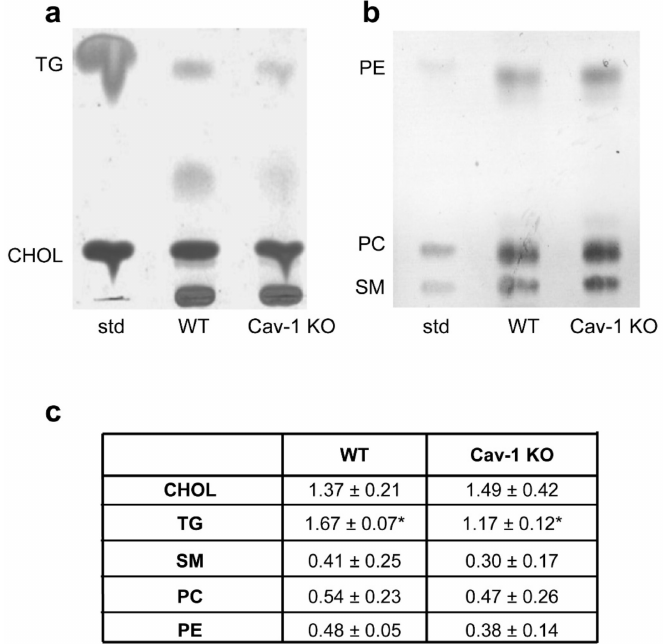
Figure 2. Characterization of DRM lipids. Post-nuclear homogenates from WT ( a ) and Cav-1 KO ( b ) lung tissue were extracted using 1% TX-100 and fractionated in 5%–30% sucrose gradient. Equal volumes of sucrose gradient fractions were subjected to high performance thin layer chromatography (HPTLC) analysis. Fractions 3–6 corresponding to DRMs showed enrichment of sphingomyelin (SM) and cholesterol (CHOL). ( c ) HPTLC chromatograms of lipids extracted from DRMs. 10 µ g of each lipid standard were spotted on the plate. Cholesterol (CHOL) and triacylglycerols (TG) analysis. Phospholipids (PE; PC) and sphingomyelin (SM) analysis. Lipid concentrations were normalized to DRM protein and calculated against the reference standard. Data are presented as mean ± s.e. ( n = 3) (* p <